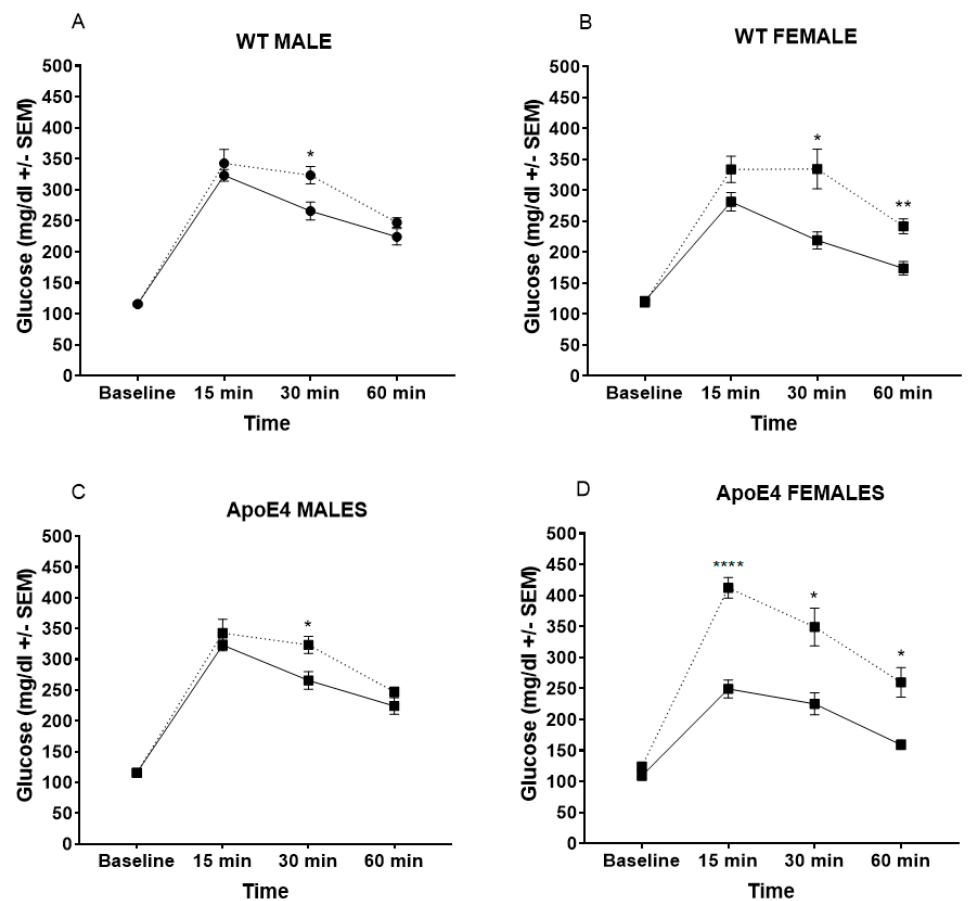
Figure 3. Glucose tolerance test. Average residual blood glucose levels in the 60 min period post- administration were elevated in all groups fed the high-fat diet. However, this effect was more pronounced in both female WT ( B ) and ApoE4 mice ( D ) than in either male WT ( A ) or ApoE4 ( C ) animals * p < 0.05, ** p < 0.01, **** p <